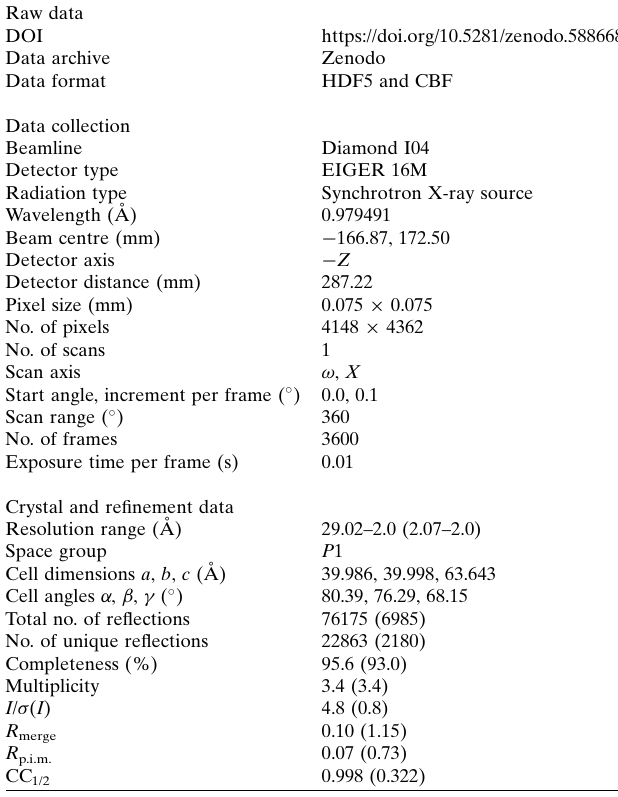
Data for the highest resolution shell are given in